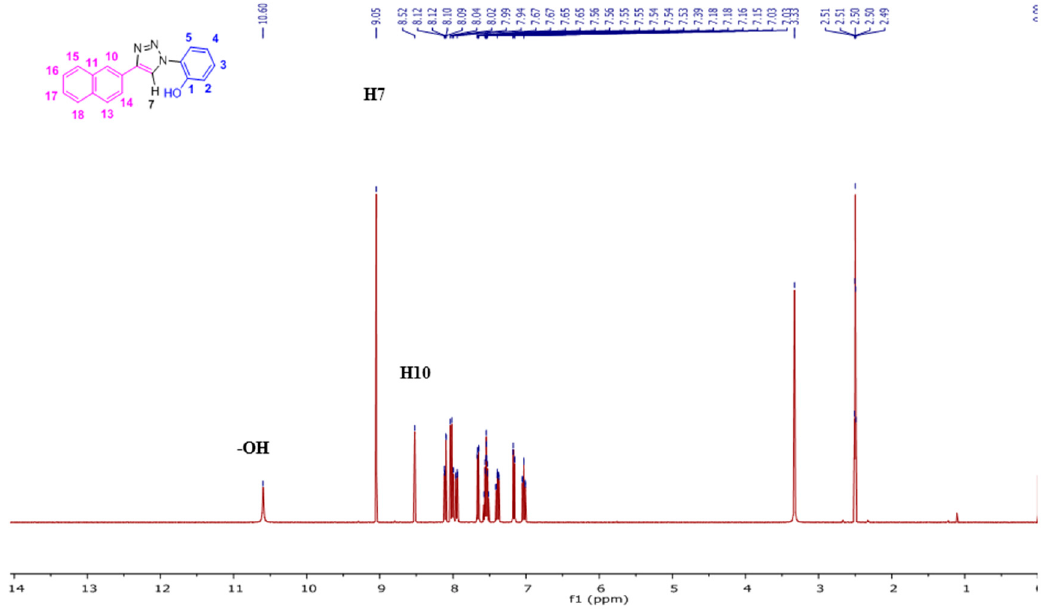
Figure 2. Full 1 H-NMR spectrum (400 MHz, (CD 3 ) 2 S=O, RT) of NpTP ; selected few peaks are assigned (for the expanded version of the aromatic region, see Figure 1).